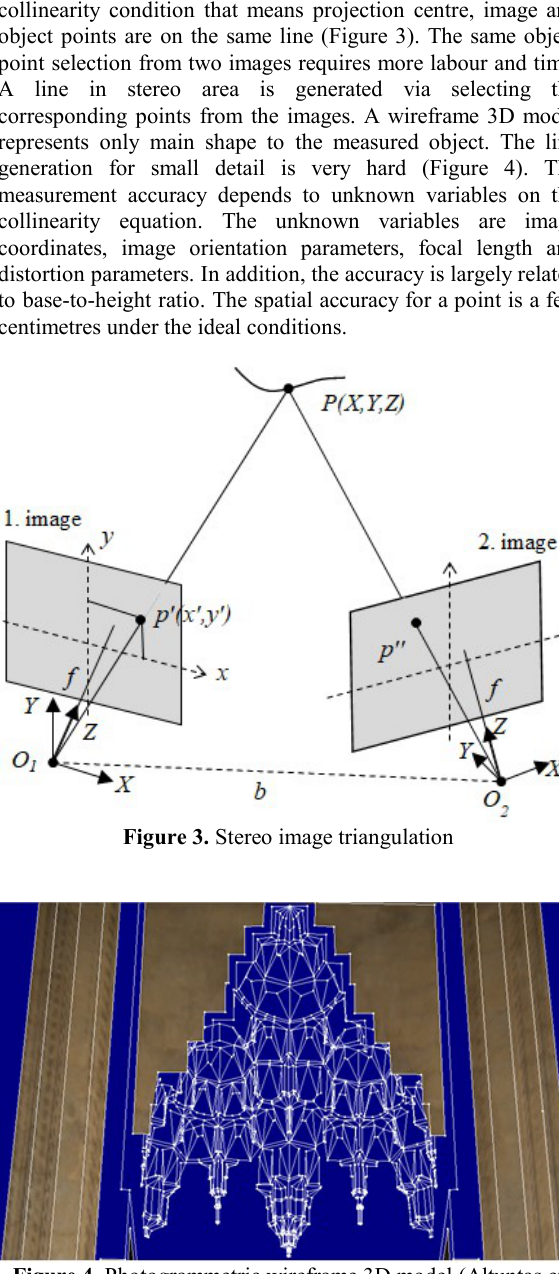
Figure 4. Photogrammetric wireframe 3D model (Altuntas et al., 2019).